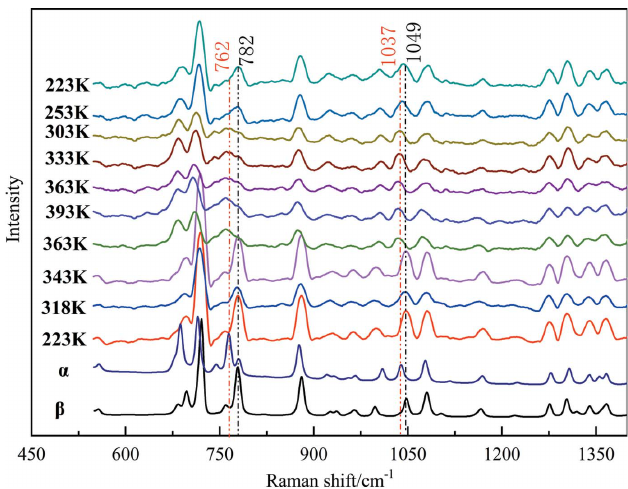
Figure 4 VT Raman spectra of polycrystalline powders after 90 min of milling. The temperature ranges are set from 223 to 393 K and from 393 to 223 K at a rate of 5 K min (cid:4) 1 . The marked peaks are those characteristic of the (cid:3) and (cid:2) forms.